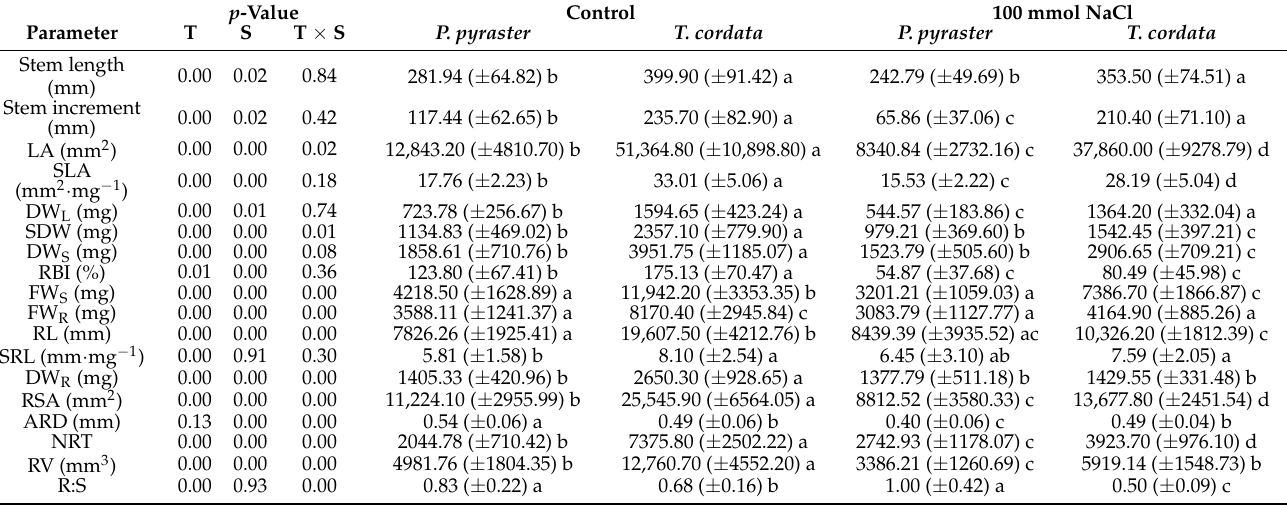
Table 2. The growth parameters and biomass allocation of P. pyraster and T. cordata seedlings in the pot experiment after 50 days of salt treatment. The multiple comparison of means ( n = 20) was performed using the 95% Tukey honest significant difference (HSD) test. Data are the mean values and standard deviations ( ± SD). Mean values followed by different letters are significantly different.